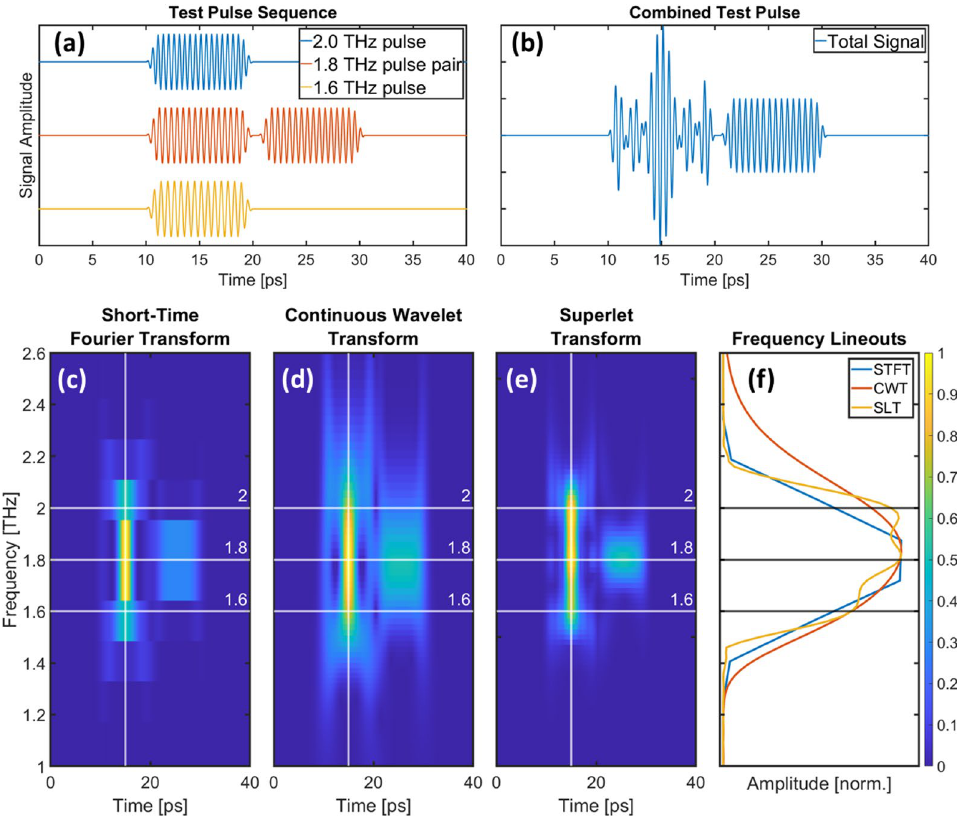
Figure 3. Demonstration of SLT performance using test pulse series. ( a ) Test pulses with frequency components 2 THz, 1.8 THz, and 1.6 THz, are summed to generate the model signal in panel ( b ). Each pulse is 10 ps in duration and the 1.8 THz component has an additional pulse delayed in time by 0.5 ps from the end of the first pulse. This model signal will let us study the temporal and spectral resolution of the three techniques. The normalized STFT ( c ), CWT ( d ), and SLT ( e ) of the model signal are shown in the bottom panels from left to right. Lineouts ( f ) of each transform taken at 15 ps (denoted by the vertical white lines in the transforms) are shown in the bottom right panel. The additional structure present in the spectral lineout of the SLT demonstrates its improved spectral resolution. Colorbar indicates relative intensity (arb.